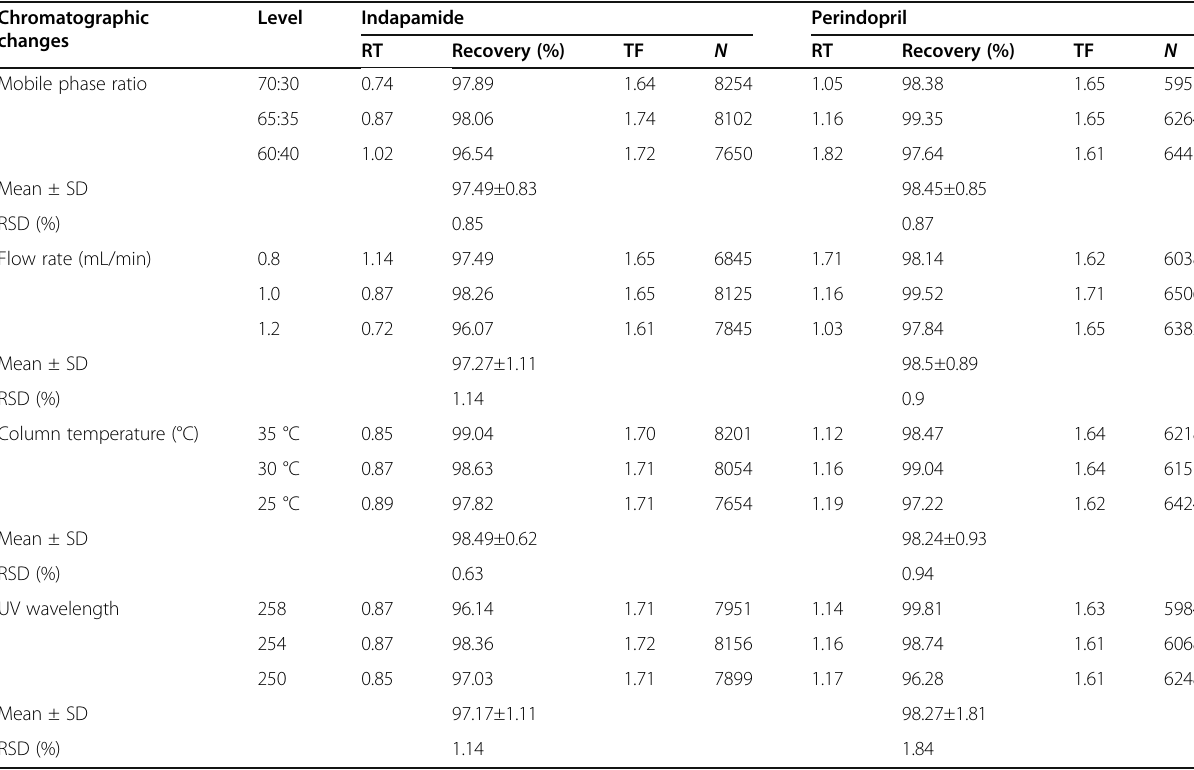
Additional file 1: Figure S2. Acidic and basic degradation HPLC